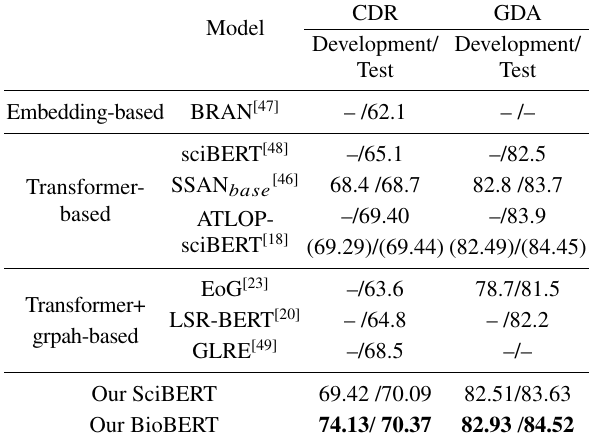
Table 3 Comparison of models CDR and GDA for F1-